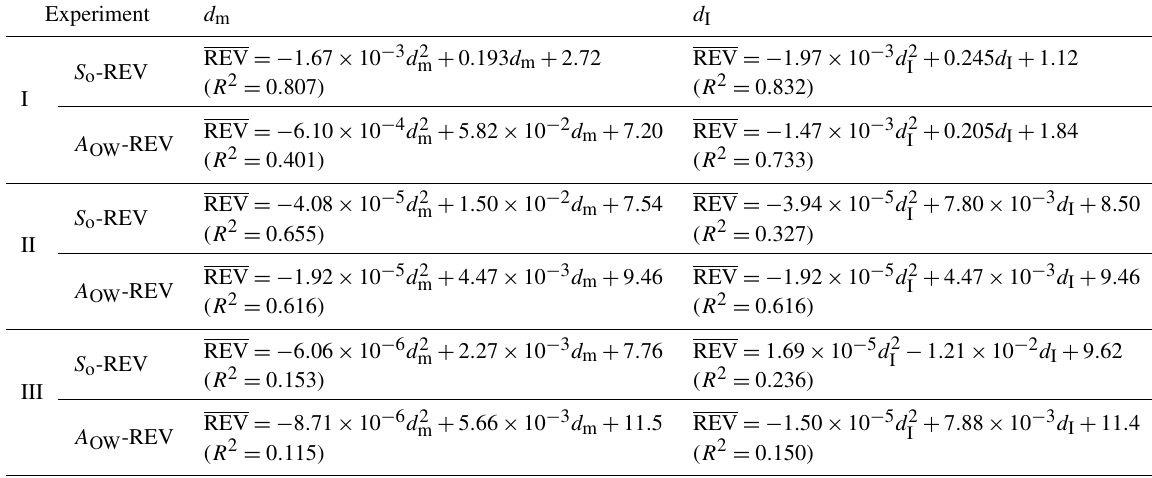
Table 3. The fitted equations between average values of REV and d I , d m .